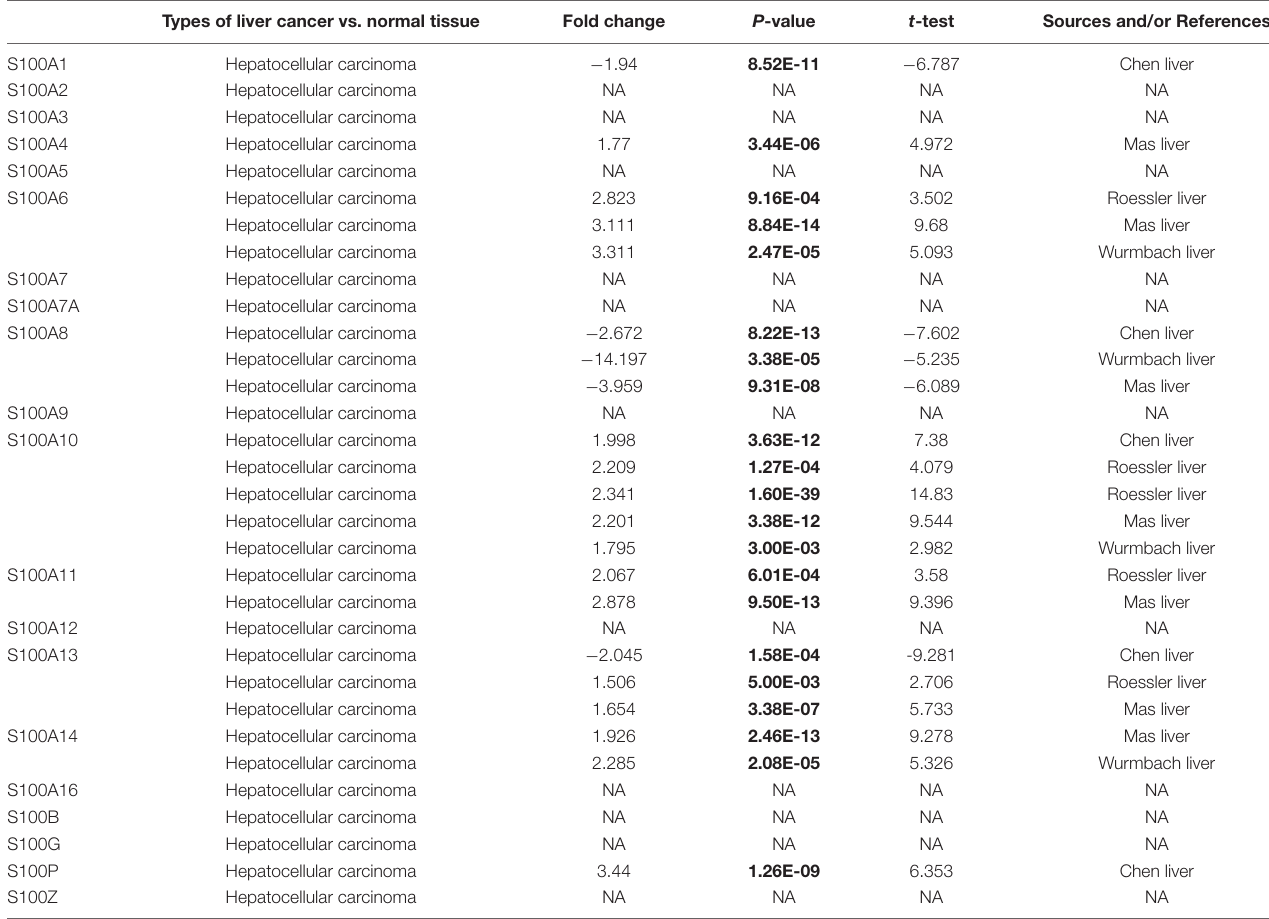
TABLE 1 | Significant changes of S100s expression in transcription level between HCC and normal liver tissues (ONCOMINE database). Types of liver cancer vs. normal tissue Fold change P -value t -test Sources and/or